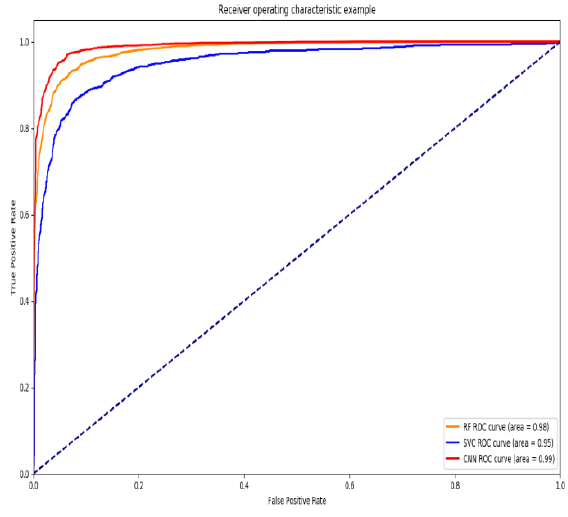
Figure 8. ROC Figure 8. ROC curve.